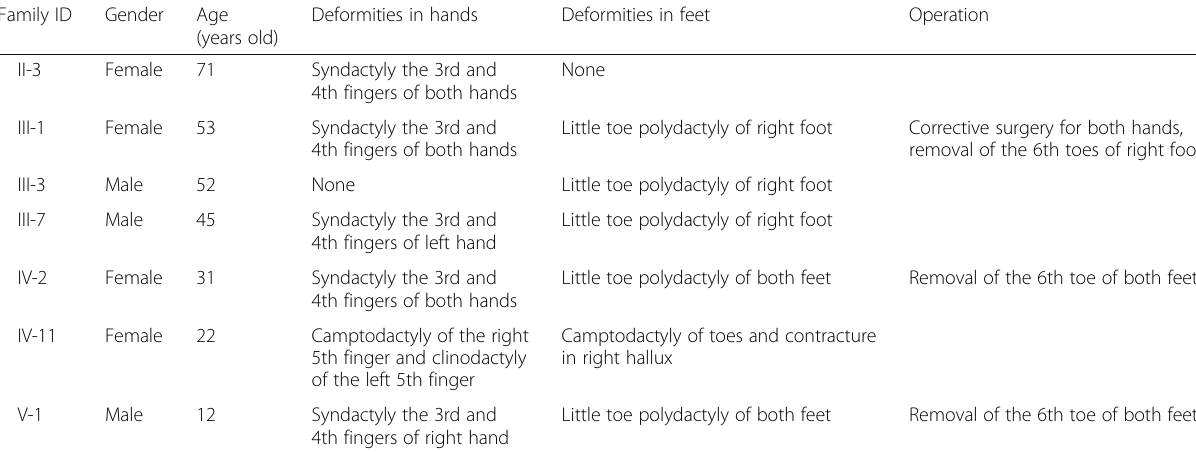
Table 1 Clinical characteristics of all affected family